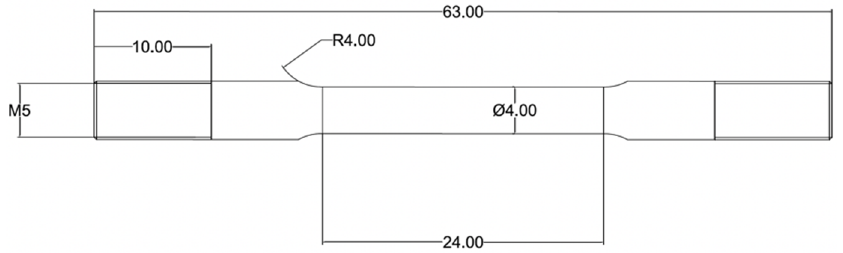
Figure 2. SSRT sample dimensions. All numbers in mm.